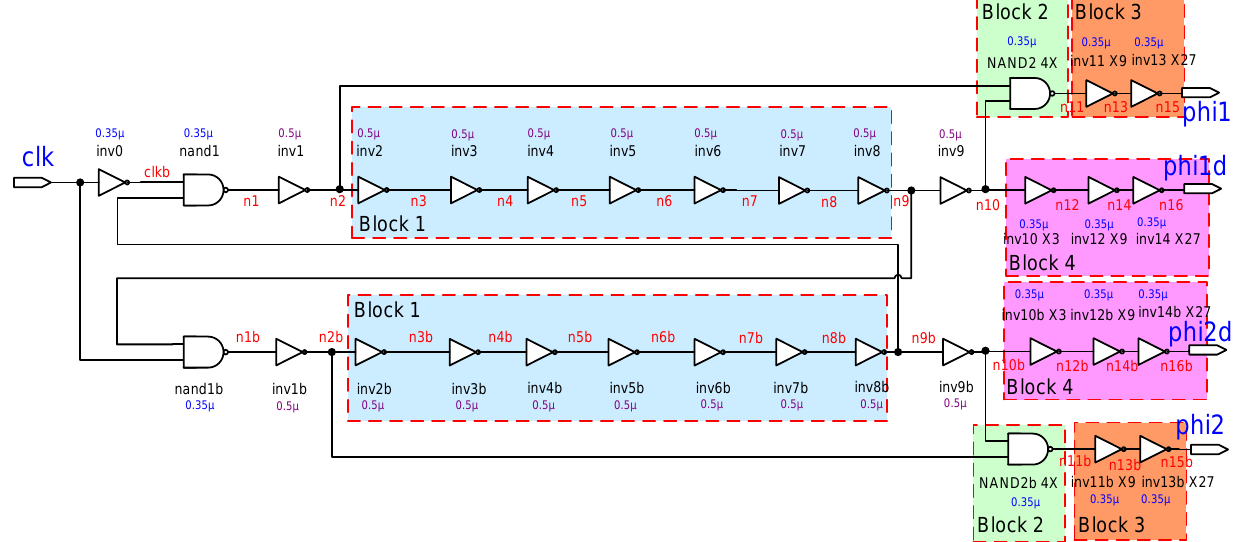
Figure 6. Schematic of the non-overlapping clock